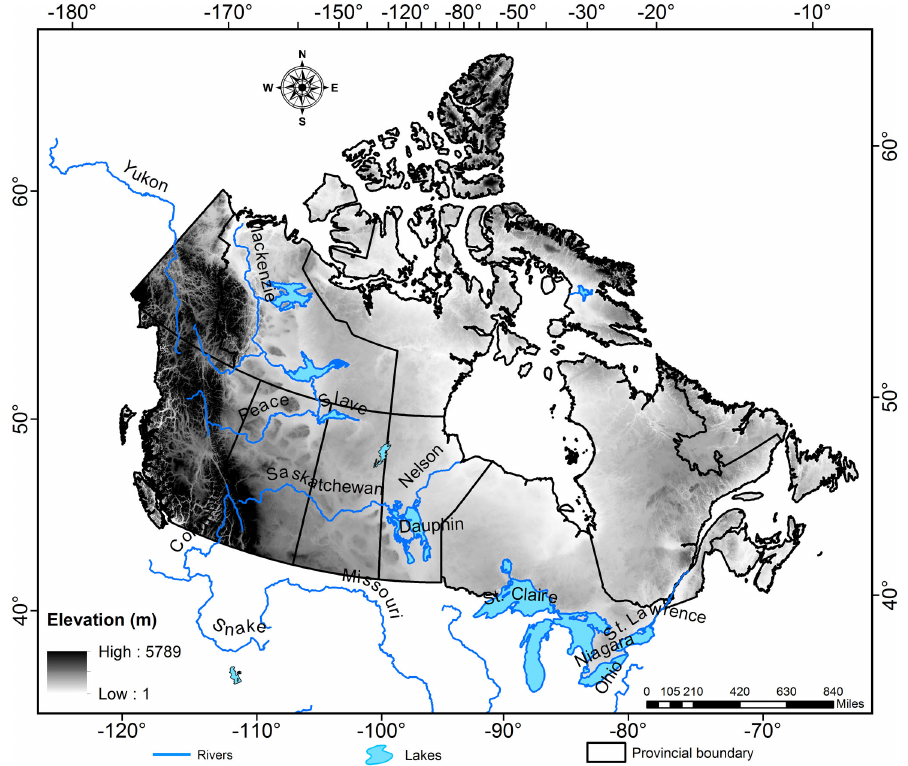
Figure 1. Study area showing topographic and hydrographic features of